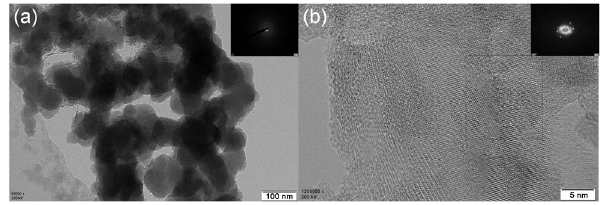
Fig. 3 (a) TEM images of RP; (b) HRTEM images of RP with ball-milling for 2 h.